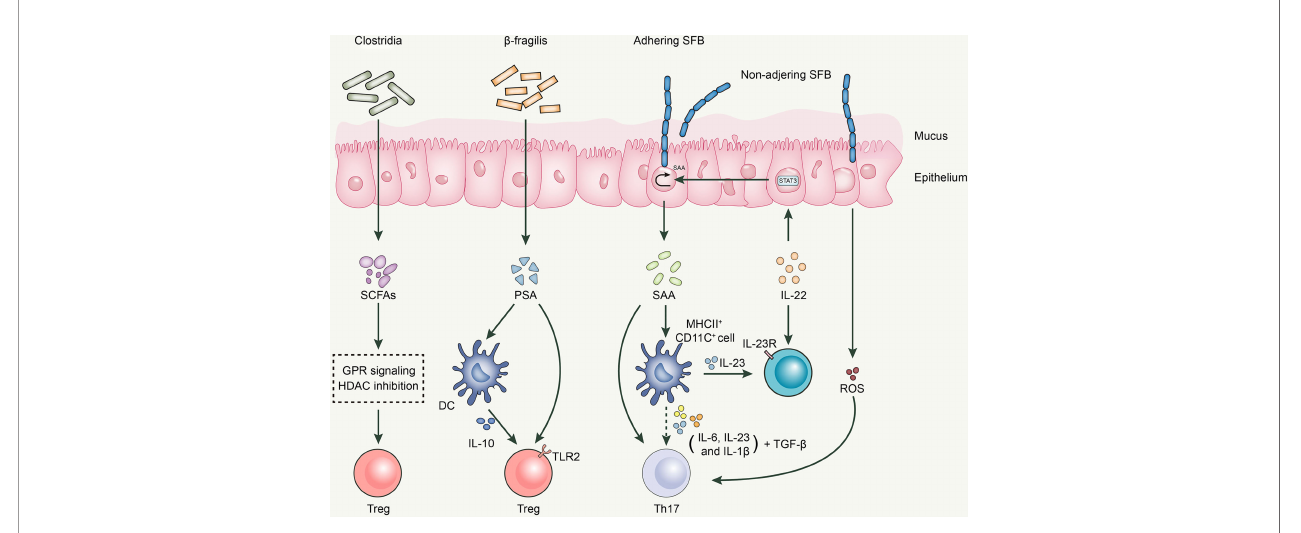
FIGURE 1 | Roles of gut microbiota in Th17/Treg